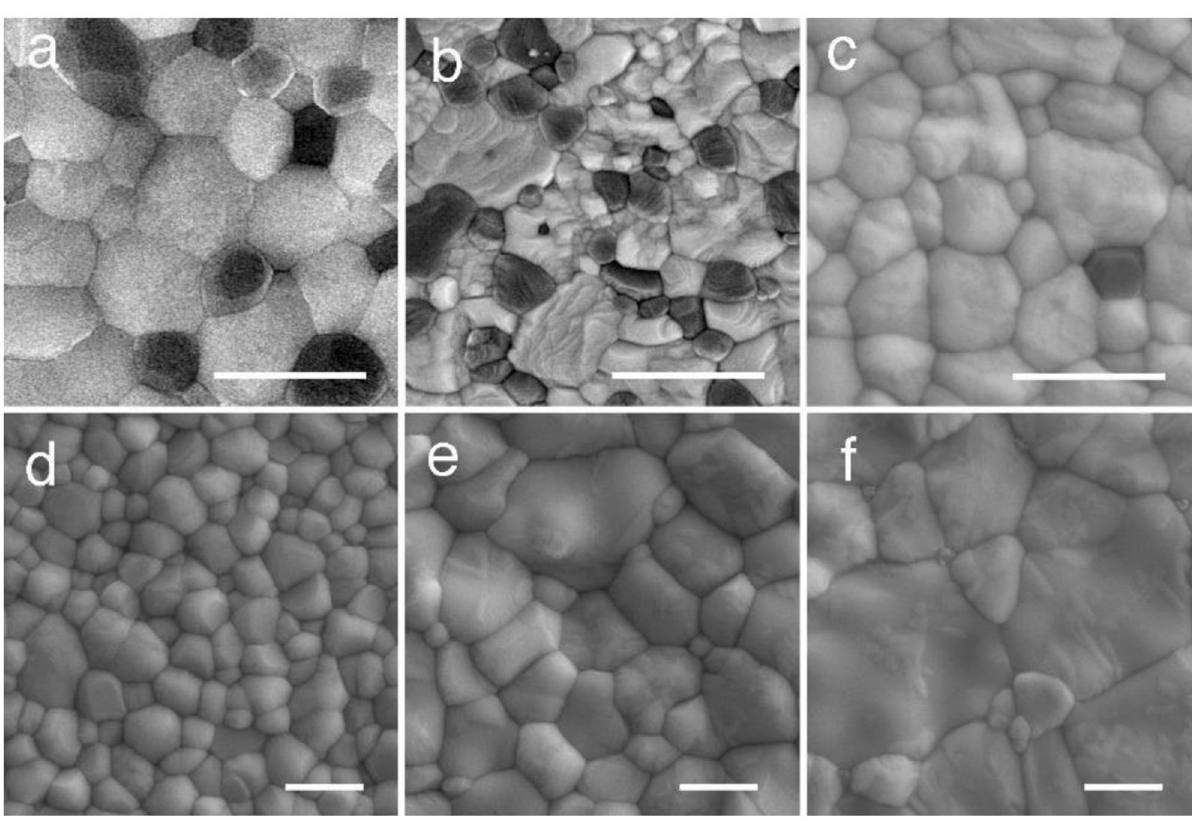
Figure 3- SEM photograph of dental zirconia. (a) ATZ; (b) NanoZR; (c) 3Y-TZP 1 st generation; (d) 3Y-TZP 2 nd generation; (e) 4Y-PSZ 3 rd generation; and (f) 5Y-PSZ 3 rd generation. White lines indicating 1 µm scale 120 ; Attribution 4.0 International (CC BY